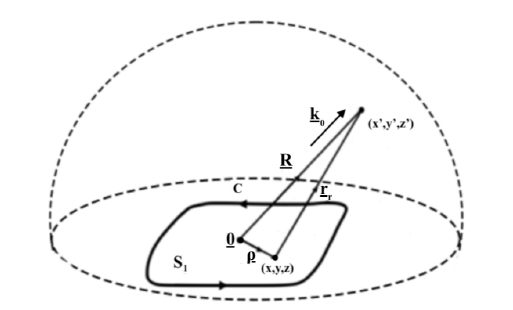
Figure 4. The finite scattering surface, S 1 , with boundary C , as part of a hemispherical surface. The vector ρ denotes the position ( x , y , z ) on S 1 ; the vector (cid:126) r r is the vector from ( x , y , z ) to some distant point ( x (cid:48) , y (cid:48) , z (cid:48) ) where the scattered electric field is desired. The vector (cid:126) k 0 is the radar wavevector in the direction of the scattered radio wave, (cid:126) R